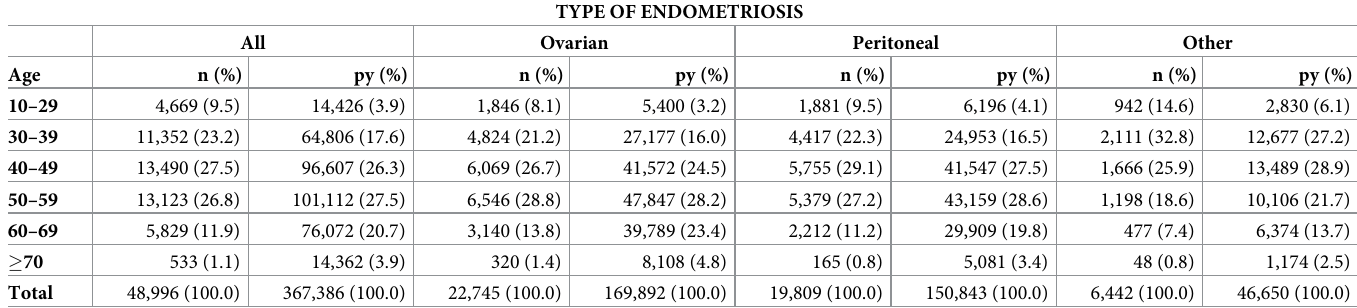
Table 1. Extraovarian clear cell cancers among women with surgically diagnosed endometriosis: Numbers of women (n) at the time of diagnosis and person-years (py) by age (years) at follow-up. TYPE OF